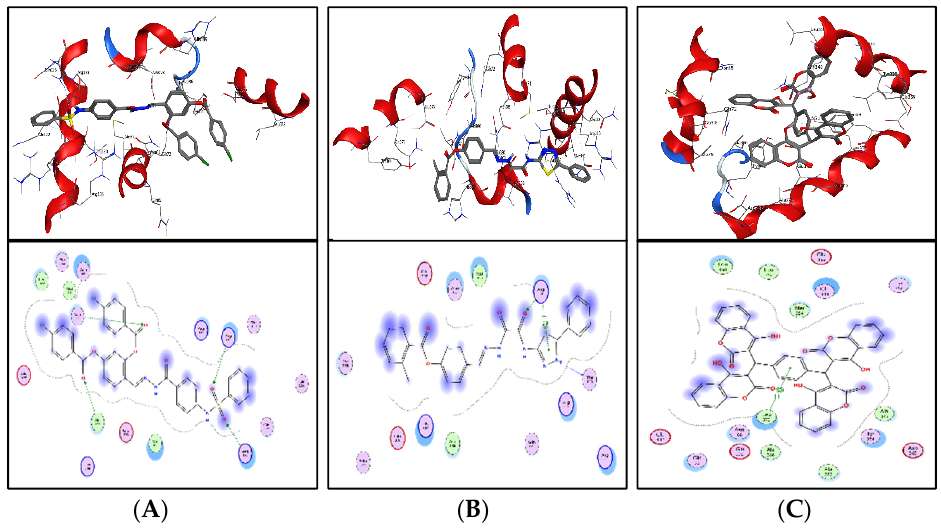
Figure 9. Molecular docking. Molecular docking analysis for the shortlisted compounds ( A ) ZINC04232055, ( B ) ZINC04259566, and ( C ) ZINC95543764.